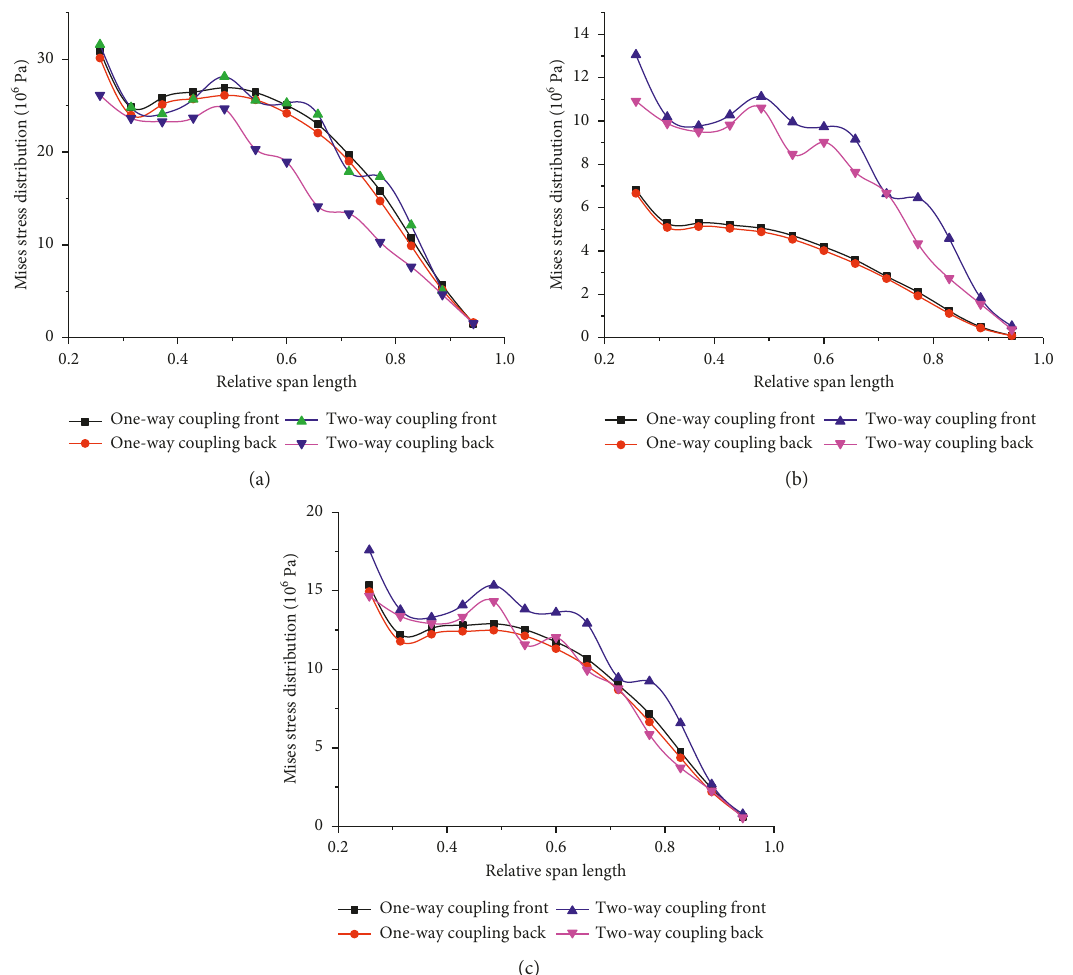
Figure 11: Mises stress distribution along the windward and leeward sides at different times under one- and two-way FSIs: (a) Mises stress distribution along the span length@0.35 s; (b) Mises stress distribution along the span length@2.75s; (c) Mises stress distribution along the span length@8.35